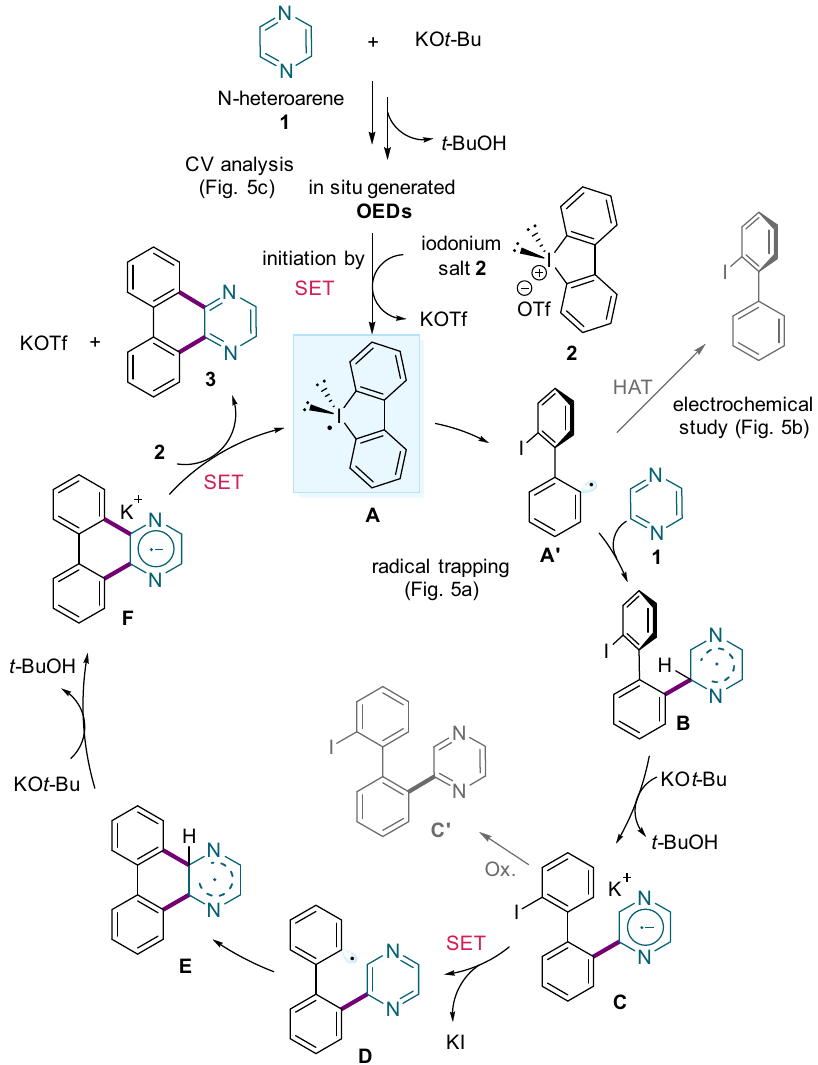
Fig. 6 Proposed iodanyl-Minisci-type APEX reaction mechanism of simple azines. This radical relay-based annulation approach allows the formation of polycyclic